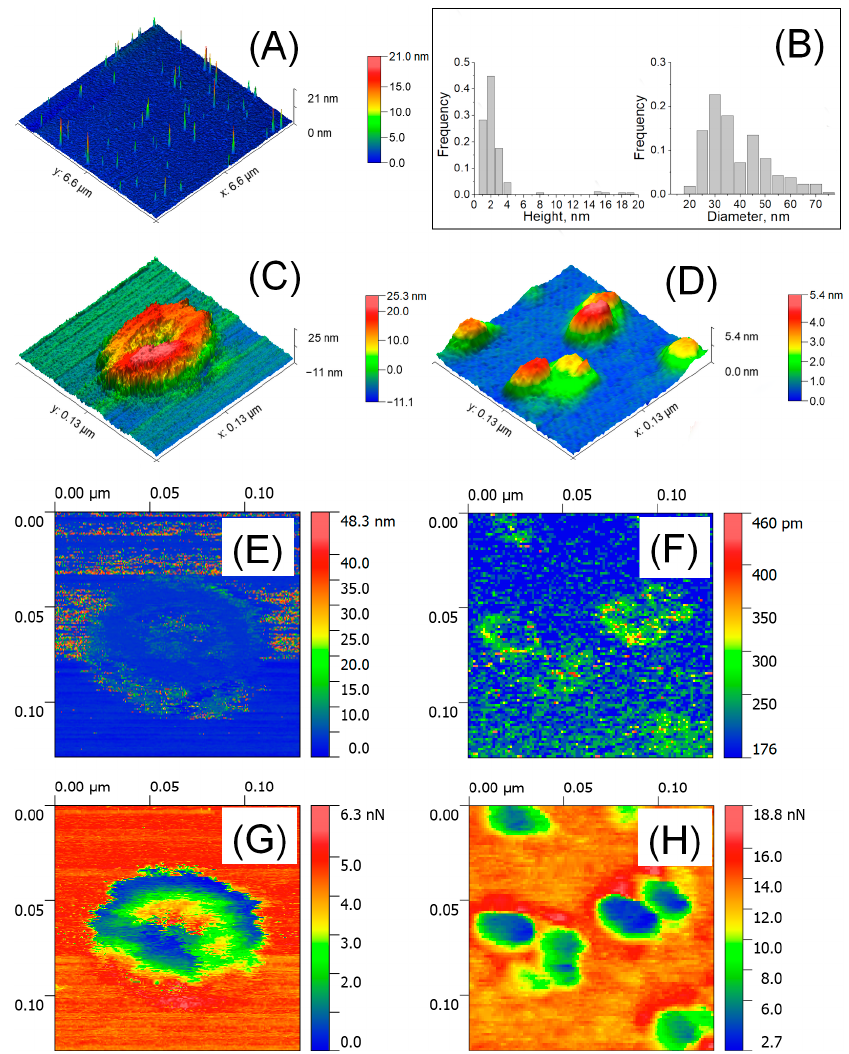
Figure 1. AFM detection of EVs in air. Large scale 6.6 × 6.6 µ m 2 AFM image ( A ) and size distribu- tion ( n = 264–299) ( B ); HR AFM image 129 × 129 nm 2 of a single exosome ( C ) and exomeres ( D ); deformation parameters ( E , F ): arrows indicated the deformed area; and adhesion forces ( G , H